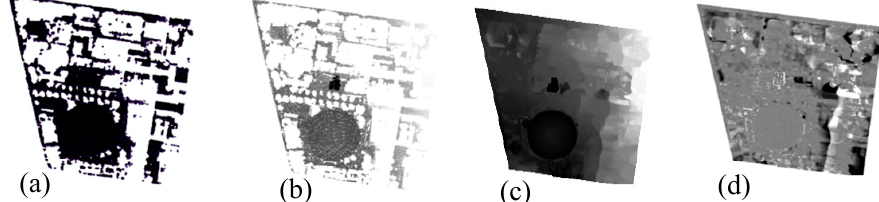
Figure 5. The process of digital elevation model (DEM) generation in the plain area, ( a ) ground points extracted from autocorrelation-based algorithm; ( b ) raster of minimum elevation; ( c ) DEM achieved from our procedure ( d ) difference between our extracted DEM and reference DEM.